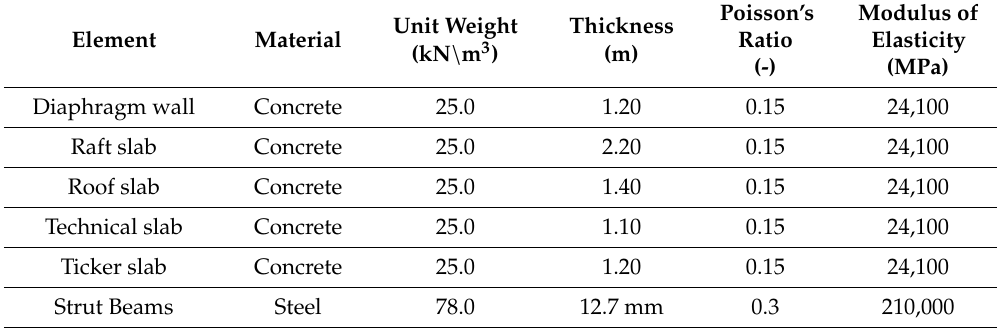
Table 2. Properties of structural